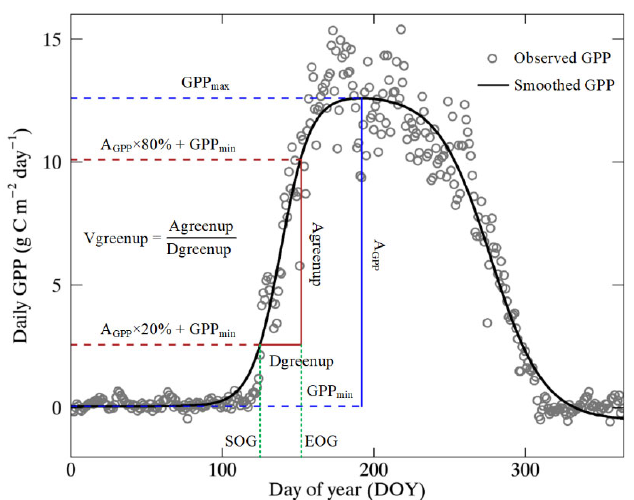
Figure 7. Scheme for determination of Dgreenup, Agreenup, and Vgreenup using daily GPP data at IT-Col site (deciduous broadleaf forest) in 2014. GPP max and GPP min represent the maximum and minimum smoothed GPP during the growth period, respectively. A GPP represents the seasonal amplitude of GPP, which is the difference between GPP max and GPP min